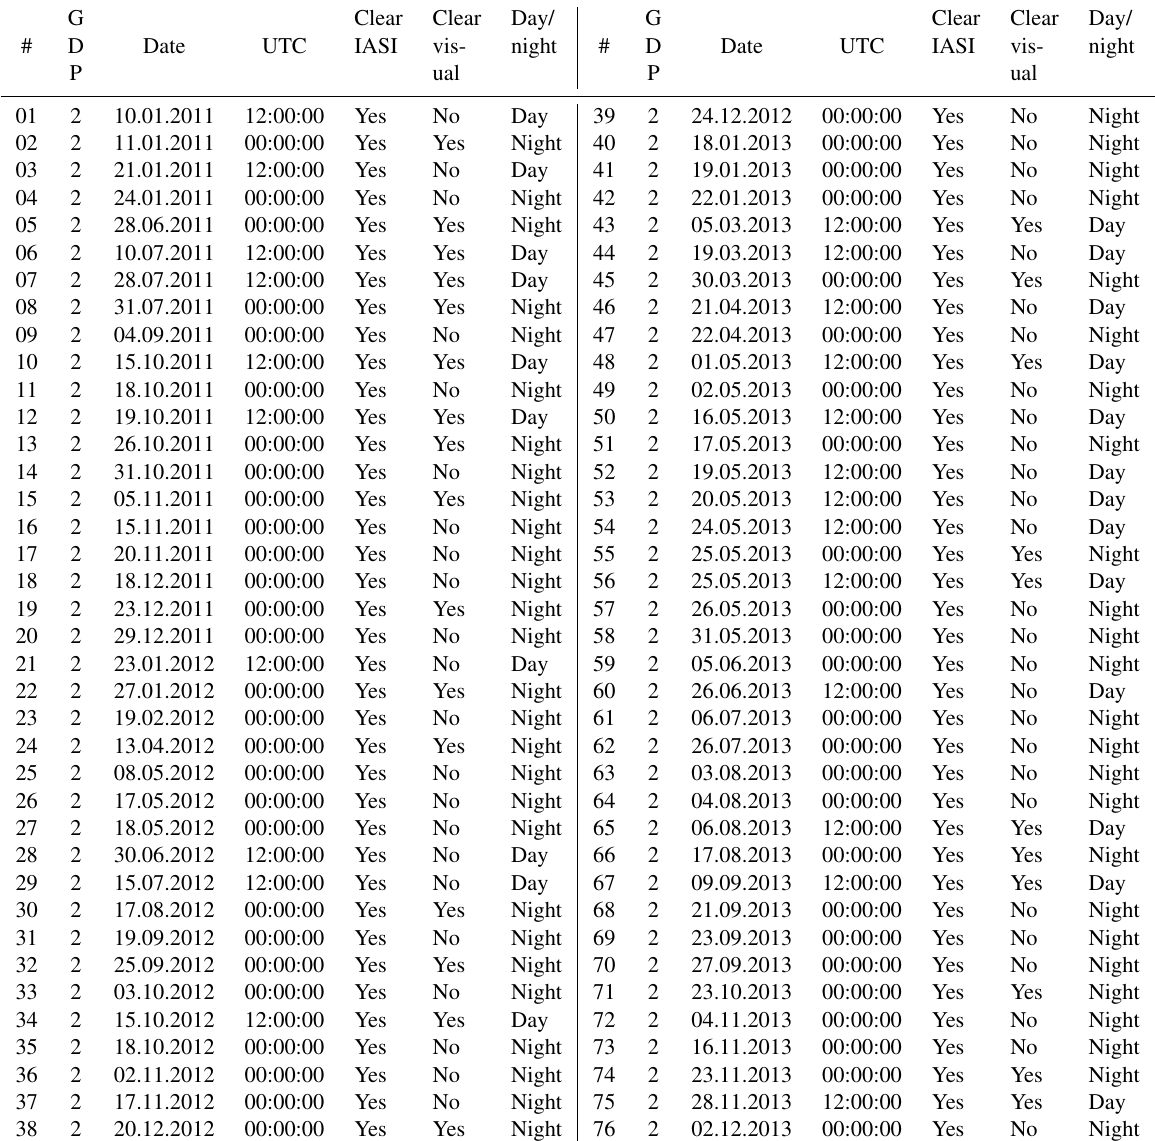
Table 2. GRUAN RS92 sondes and IASI collocation cases over Manus, where only the clear-sky cases according to IASI L1c cloud fraction are